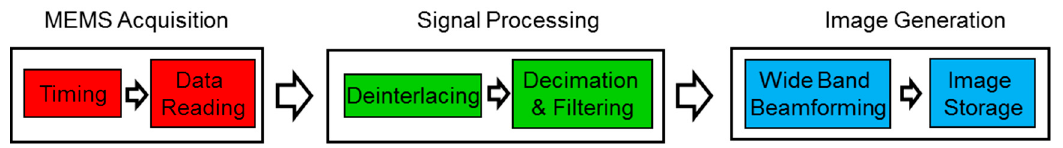
Figure 4. Software algorithms diagram.